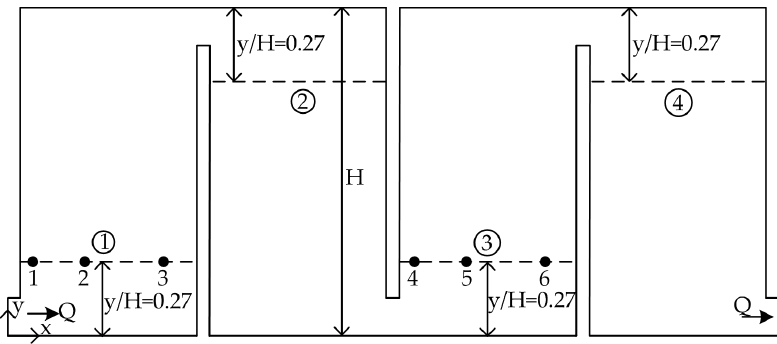
Figure 3. Sampling lines and points on the x – y plane at midspan ( z = L /2).